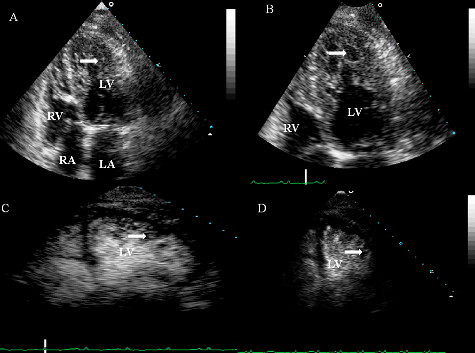
Transthoracic echocardiogram (A, B, C, D) four chamber view with albumin contrast showing numerous trabeculations (white arrow) in the left ventricular apex, along with deep intertrabecular recesses. (RA- right atrium, LA- Left atrium, RV-right ventricle, LV- left ventricle).